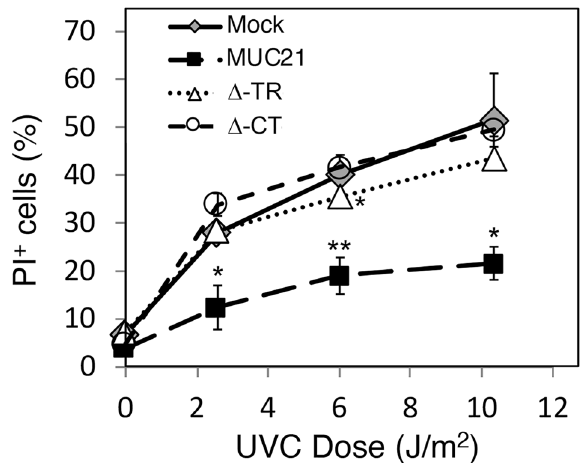
Fig. 4 Anti-cell death effect of MUC21 was observed when cell death was induced in HEK293 – MUC21 transfectants by ultraviolet irradiation. Dose – response curve of the effect of ultraviolet irradiation (UVC) on the percentage of propidium iodide-positive (PI + ) cells in mock transfectants, MUC21 full-length transfectant (MUC21), transfectants with MUC21 lacking the tandem-repeat domain ( Δ -TR), and transfectants with MUC21 lacking the cytosolic domain ( Δ -CT). Means (SD) of three independent experiments are shown. Two-way ANOVA with Dunnett ’ s multiple-comparison test. * p < 0.05, ** p <